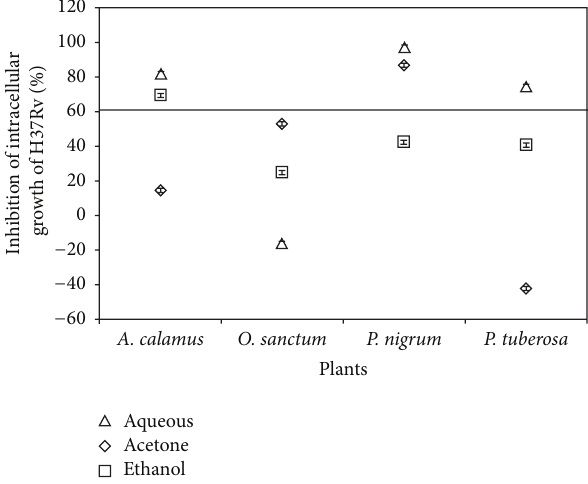
Figure 2: Intracellular inhibition of growth of H37Rv. Extracts of 4 plants were tested on intracellular growth of H37Rv in A549 cells at 25 𝜇 g/mL with MOI of 1: 1. The extracts showing greater than 60% inhibition of bacterial growth 10 days after infection were selected for testing under anaerobic conditions in an axenic setup.